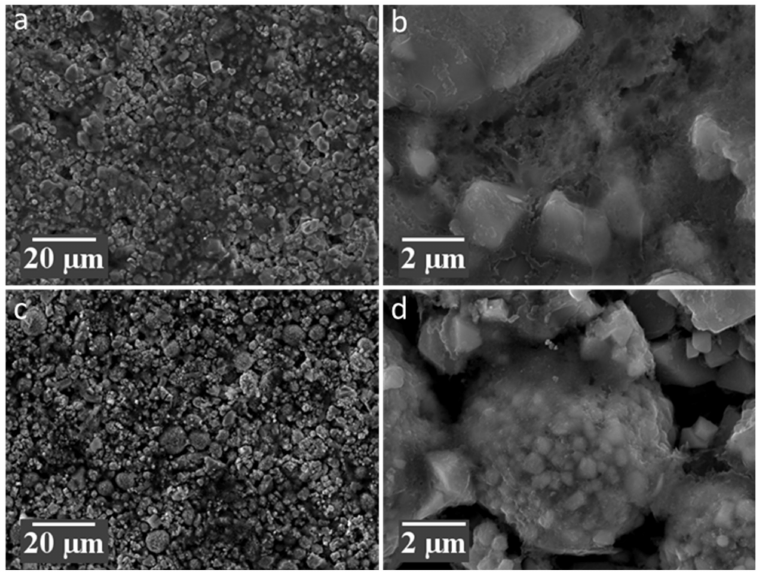
Figure 6. SEM images of the reclaimed cathode black mass for ( a,b ) QC rejected cells and ( c,d ) end of life cells.